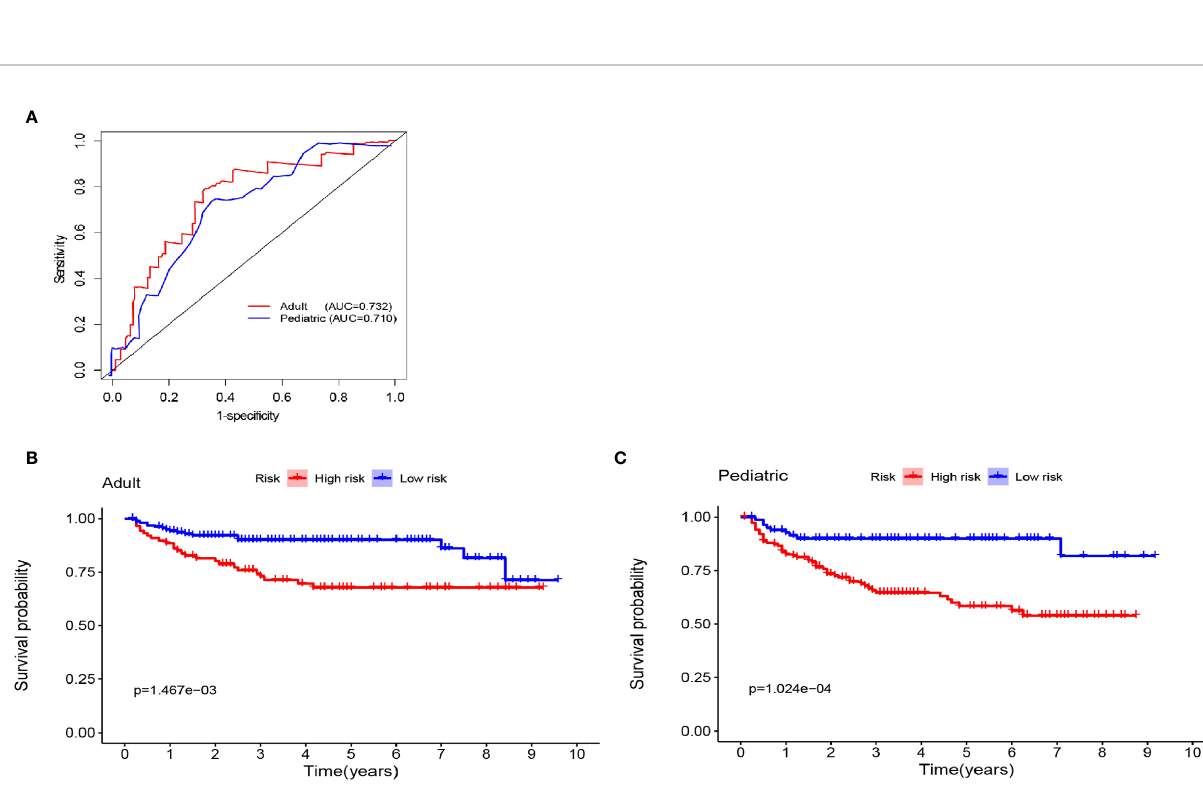
FIGURE 8 | (A) Nomogram for predicting the extent of resection in adult and pediatric cohort. The KM curves for high-risk group (red) and low-risk group (blue) in the adult (B) and pediatric cohort (C)